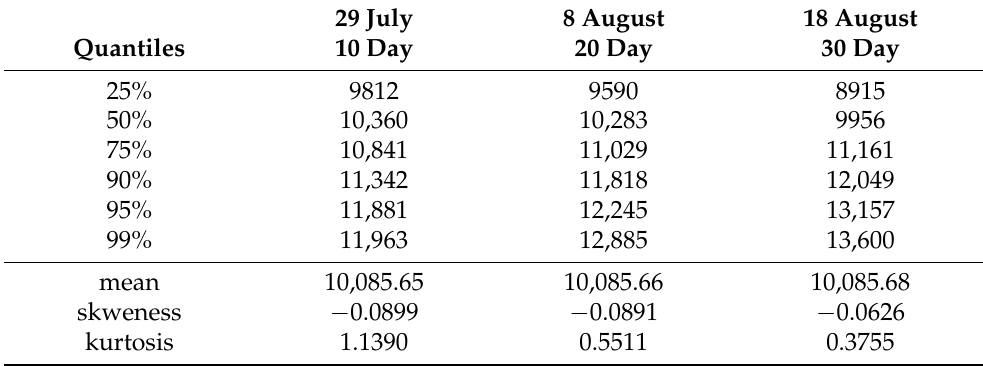
Table 1. Percentiles of